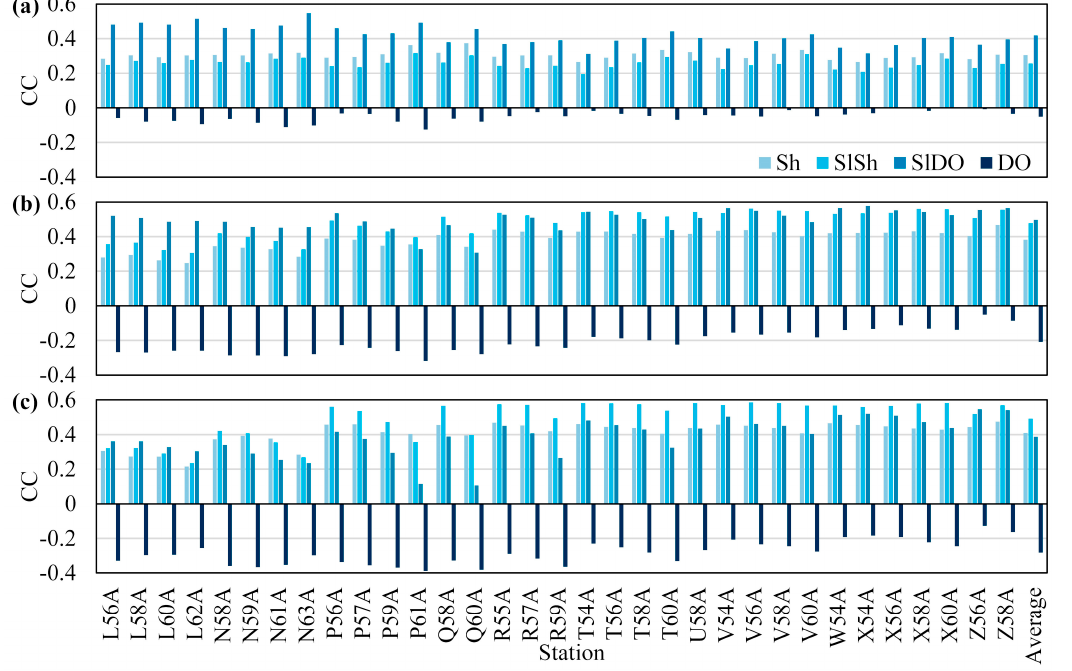
Figure 5. Average Pearson correlation coefficients (CC) between the PSDs in the three DF bands and the ocean wave heights in four groups of ocean